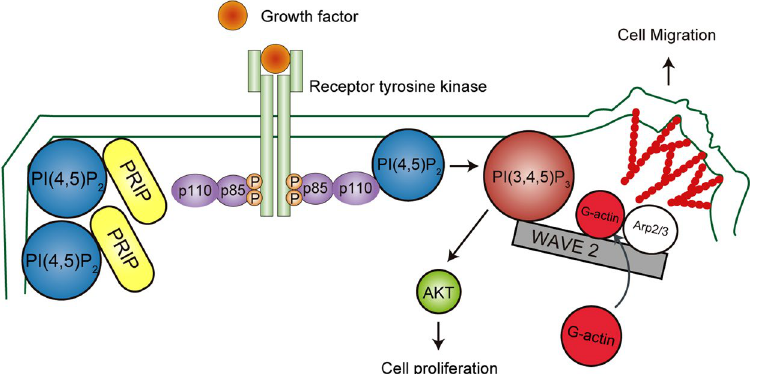
Figure 8. Schematic representation of PRIP-mediated cell migration. PRIP binds to PI(4,5)P 2 via its PH domain and sequesters PI(4,5)P 2 from a metabolizing enzyme PI3K. This inhibits the interaction between p110 α , catalytic subunit of PI3K, and PI(4,5)P 2 . When PI3K is activated by growth factor stimulation, the excessive metabolism to PI(3,4,5)P 3 is protected by the proper access of the PI3K to PI(4,5)P 2 . PRIP is a negative modulator for PI(3,4,5)P 3 -WAVE2-induced actin polymerization and cell migration. PI3K: a heterodimer between a p110 catalytic subunit and a p85 regulatory